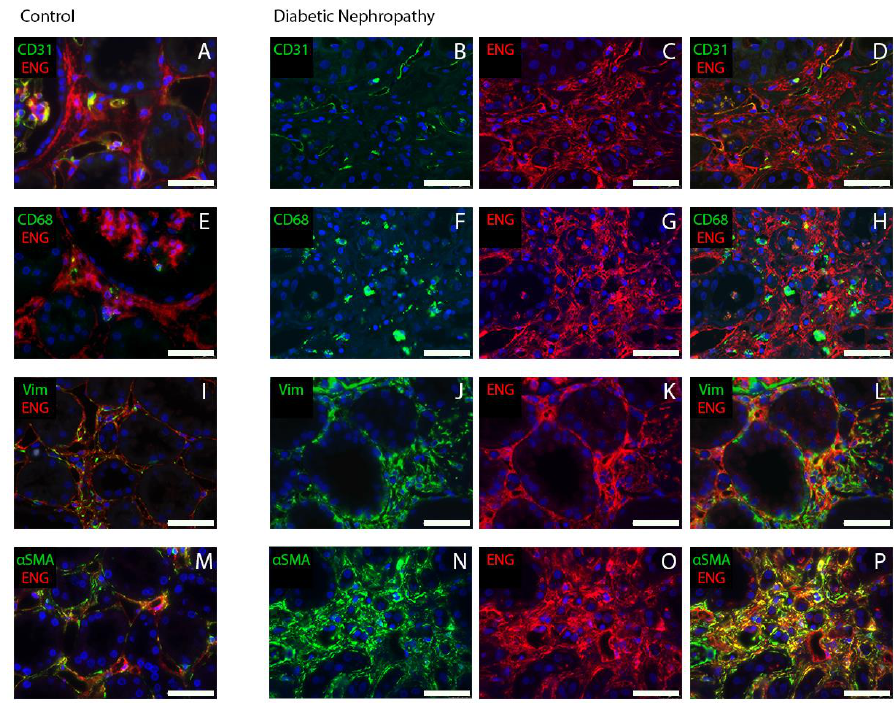
Figure 3. Endoglin is co-localized with the myofibroblast marker α-SMA. Kidney biopsy samples from non-diabetic controls ( A , E , I , and M ) and patients with DN ( B – D , F – H , J – L , and N – P ) were co-immunostained for endoglin (red) and the endothelial cell marker CD31 ( A – D ), the macrophage marker CD68 ( E – H ), the fibroblast marker vimentin ( I – L ), or the myofibroblast marker α-SMA ( M – P ). Note the co-localization of endoglin and the endothelial marker CD31 in blood vessels, the co-localization of endoglin and the fibroblast marker vimentin, as well as the co-localization of endoglin and the myofibroblast marker α -SMA, particularly in the patients with DN ( H ). The scale bars represent 50 µ m.